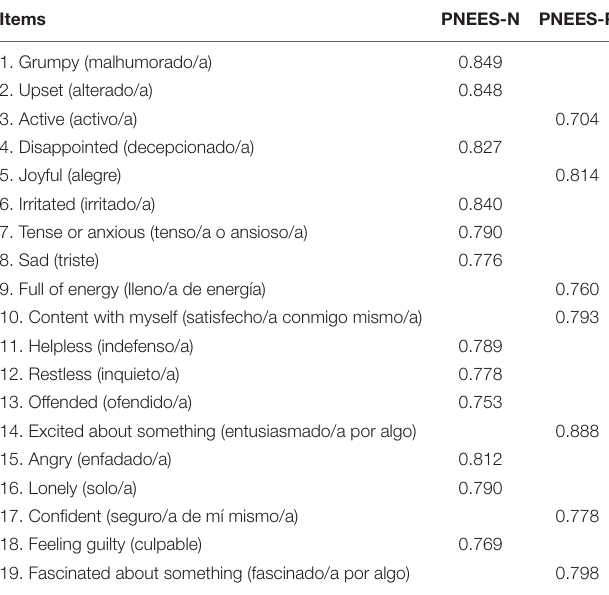
TABLE 1 | Parameter estimates of the two factors. TABLE 2 | Descriptive analysis and correlations between negative and positive emotional eating and other variables.